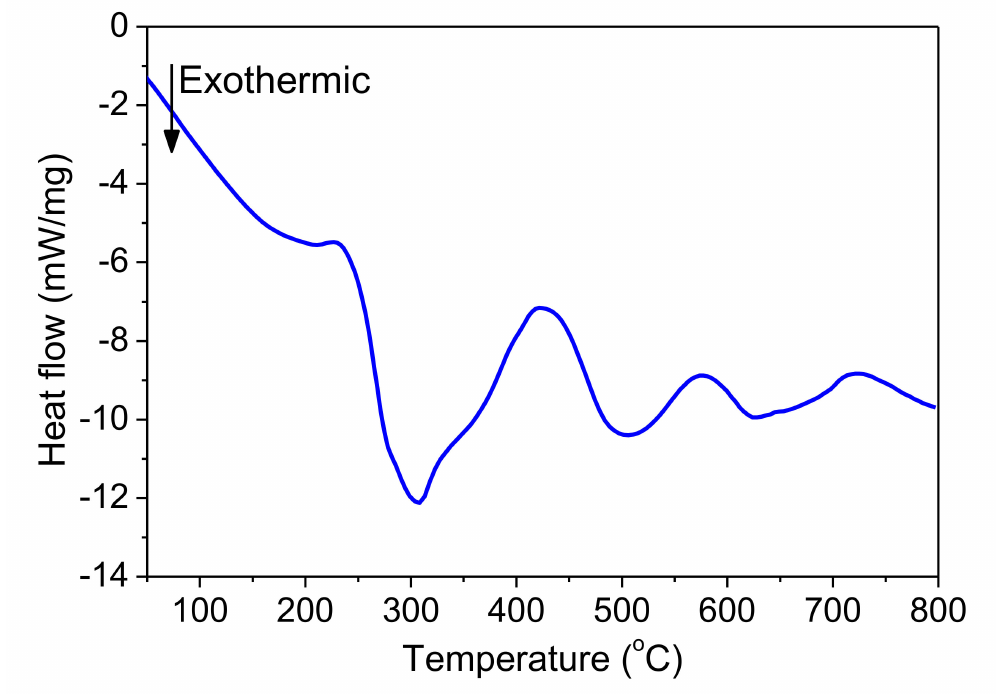
Figure 18. DSC characterization of the as-deposited Pd/Al-Ni/Al MS-iRMS.